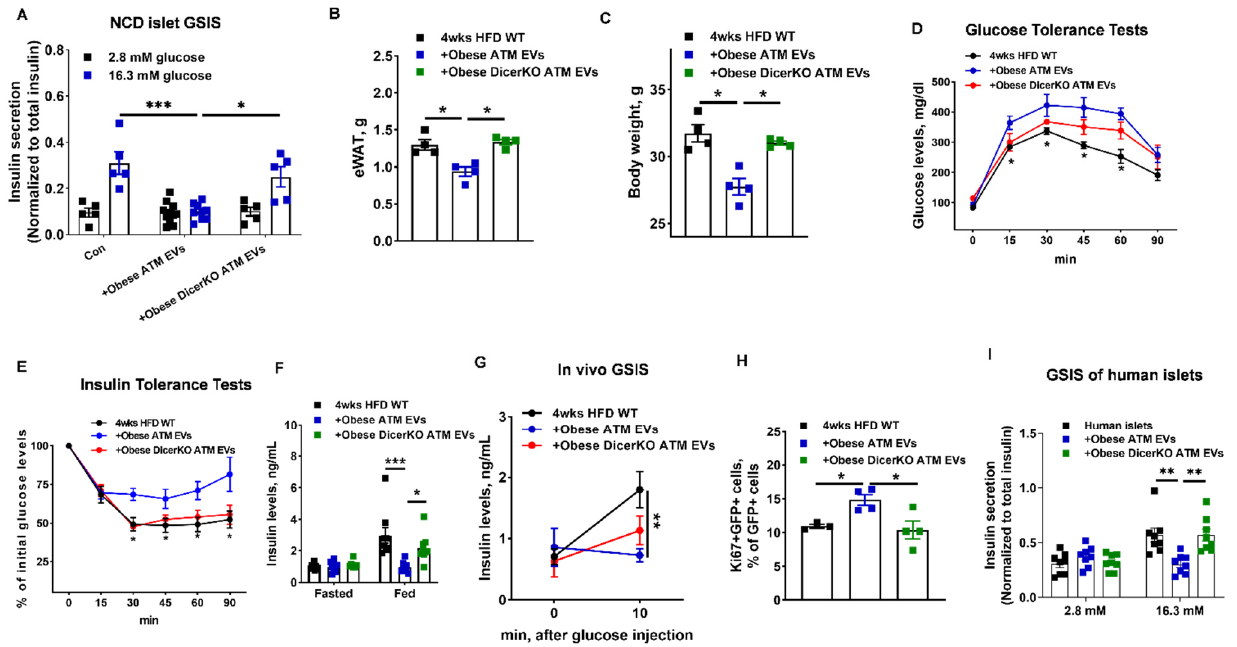
Figure 4. The importance of miRNAs in obese ATM EVs. ( A ) The GSIS of NCD islets after either obese ATM EV or obese DicerKO ATM EV treatment. After 4 weeks obese ATM EV or obese DicerKO ATM EV treatment, the epididymal fat mass ( B ), body weight ( C ), glucose and insulin tolerance tests ( D and E ), insulin levels after 16 h fasting or feeding ( F ), and glucose-stimulated insulin levels ( G ) of HFD recipients were measured. ( H ) The effect of obese ATM EVs on Ki67+GFP+ cell population of 4 weeks HFD MIPGFP-Mki67 mice. ( I ) The GSIS of human islets after either obese ATM EV or obese DicerKO ATM EV treatment. Data are presented as the mean ± SEM. D and E , G , N = 5 per group. * p < 0.05, ** p < 0.01, *** p < 0.001, one-way ( B , C , G and H ) or two-way ( A , D , E , F and I ) ANOVA.